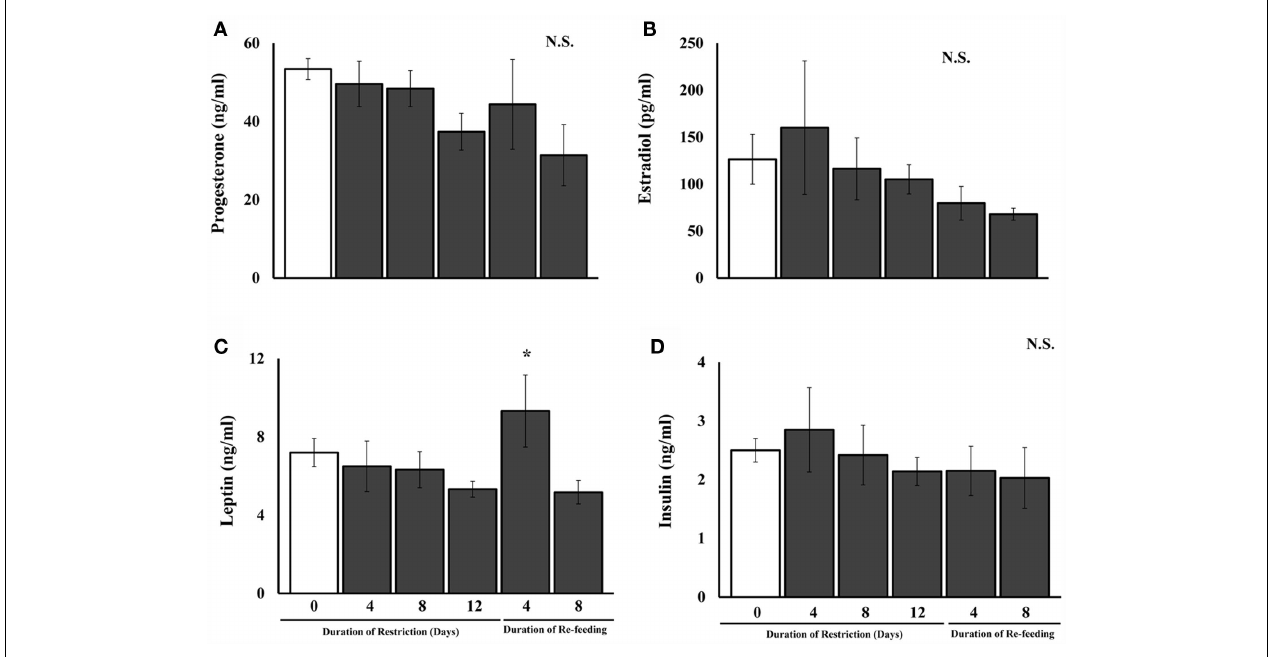
intake at 4, 8, or 12days after the start of food restriction or after 12days of restriction and either 4 or 8days of re-feeding in Experiment 1. *Significantly different from ad libitum at P <